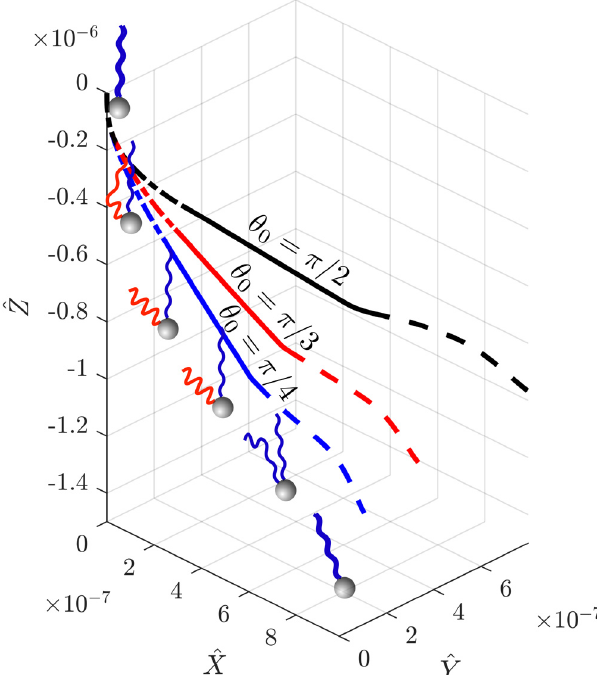
Fig 7. Trajectory of a model bacterium with two flagellar filaments during a single tumble in which one flagellum unbundles and undergoes polymorphic transformation (normal to semi-coiled and back to normal). The dash- dotted line represents the cell motion during unbundling; the solid line shows the dynamics of the cell when the unbundled filament is in its semi-coiled form; finally the dashed line shows the cell motion during the bundling motion. The three different trajectories are for different values of θ 0 (the polar angle between the bundle and the semi- coiled filament): π /4 (blue), π /3 (red) and π /2 (black). A schematic representation of a bacterium undergoing a tumble is shown next to the blue curve for θ 0 = π